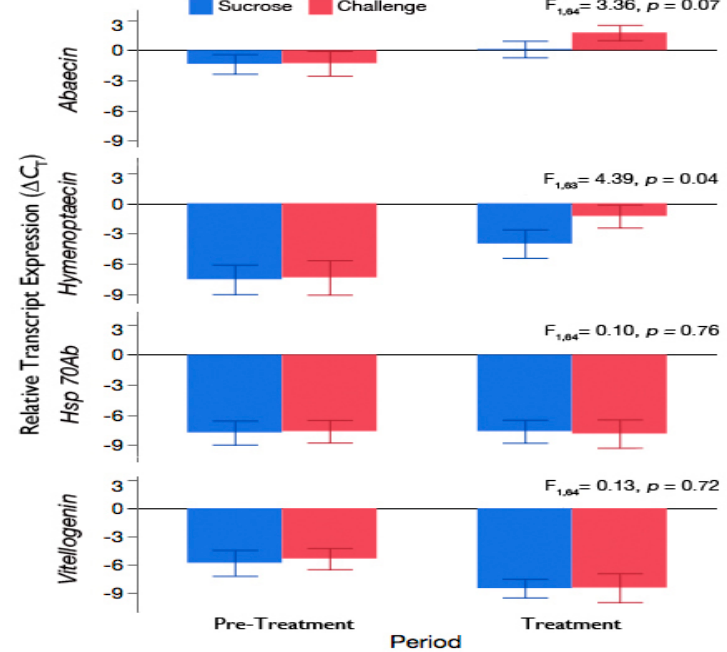
Figure 4. Mean transcript expression ( ± 95% CI) of the honey bee antimicrobial peptides, abaecin and hymenoptaecin, the thermo-responsive heat shock protein 70 Ab-like ( Hsp 70Ab-like ), and the nutritional marker vitellogenin normalized to the reference genes β -actin and ribosomal protein S5 ( RPS5 ). Newly-emerged workers were placed in cages and fed sucrose solution until day 7 (Pre-Treatment) and given either sucrose solution alone (Sucrose) or A. apis inoculum in sucrose solution (Challenge) from day 7–14 (Treatment). A subsample of workers was collected from replicate cages at the end of both periods (n = 7 or 8 workers / cage, 3 cages / treatment group) for the RT-qPCR analysis.